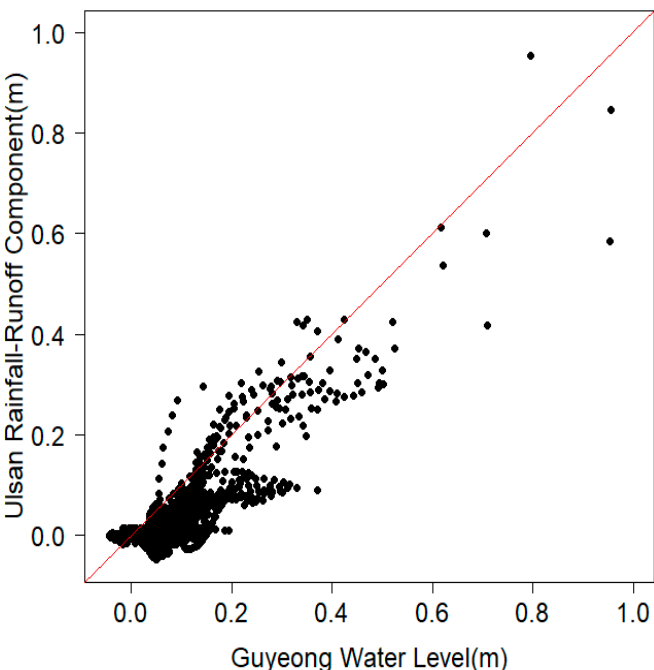
Figure 12. Scatter plot of standardized stream water level and rainfall-runoff Figure 10. Scatter plot of standardized stream water level and rainfall-runoff component.